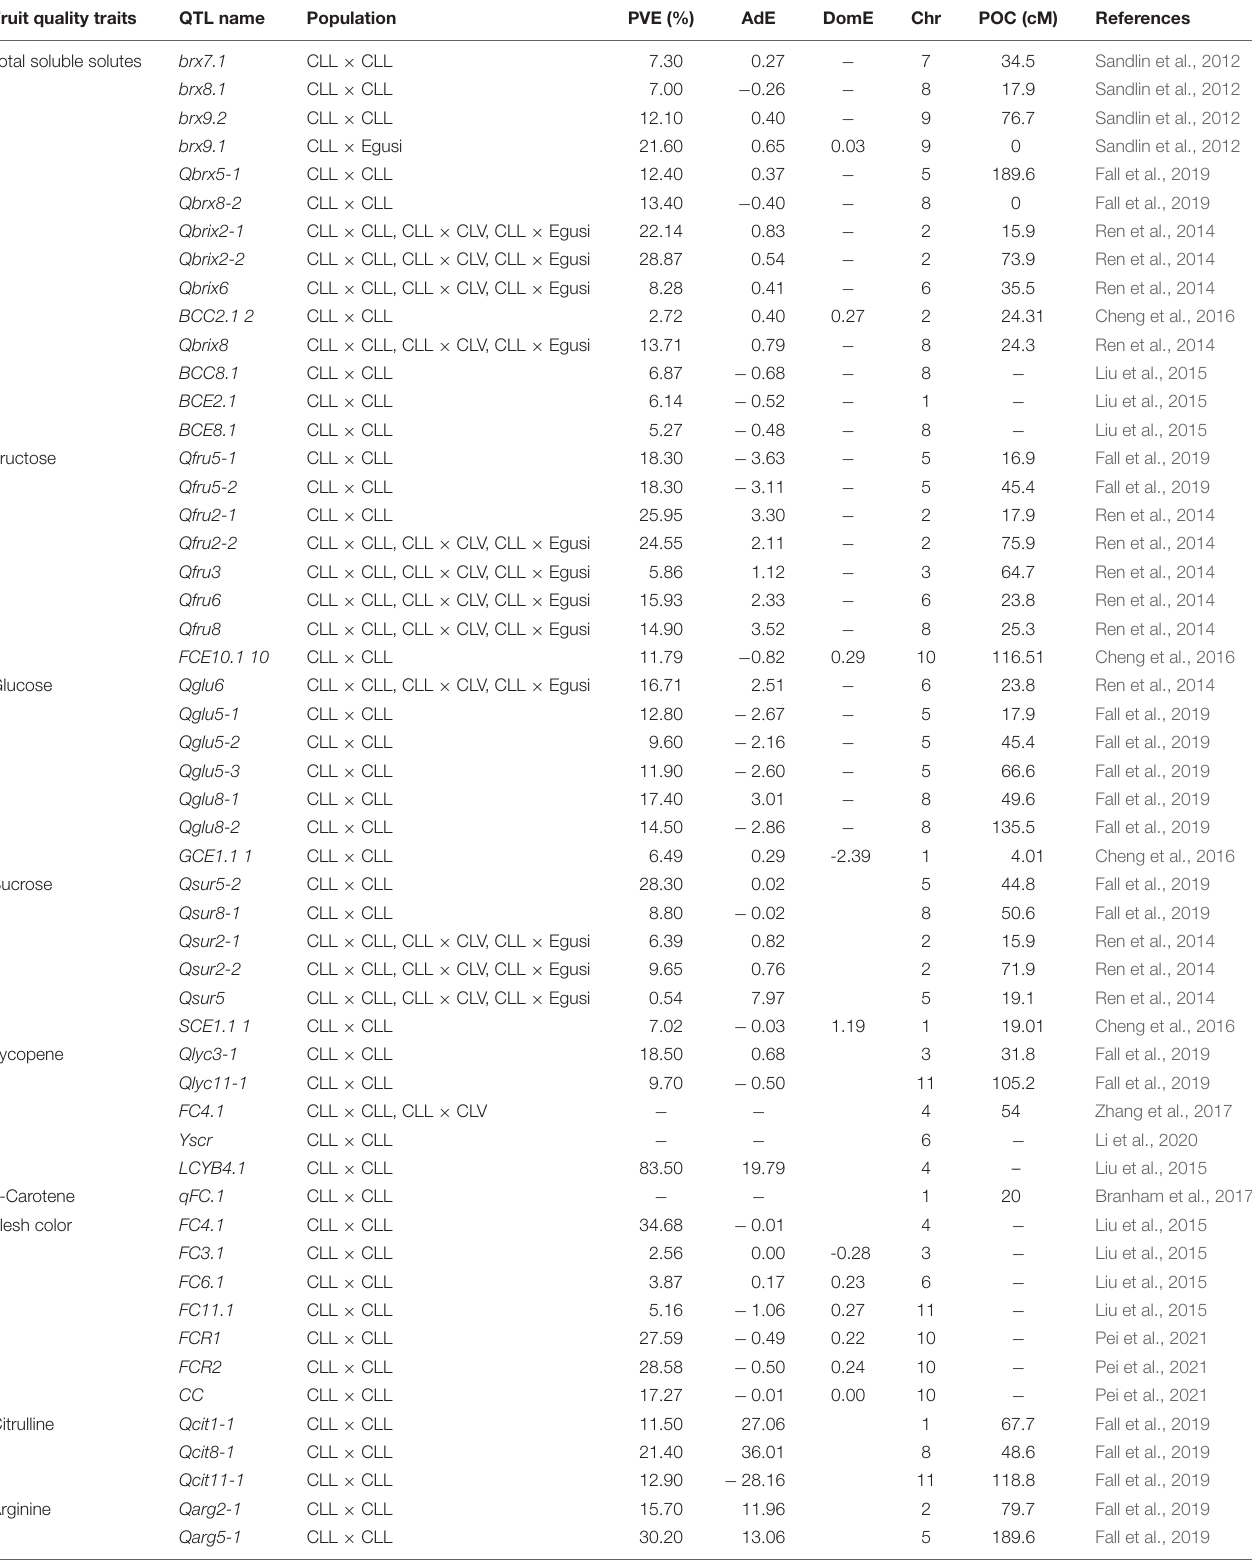
TABLE 1 | Reported quantitative trait loci (QTLs) associated with fruit quality traits in watermelon. Fruit quality